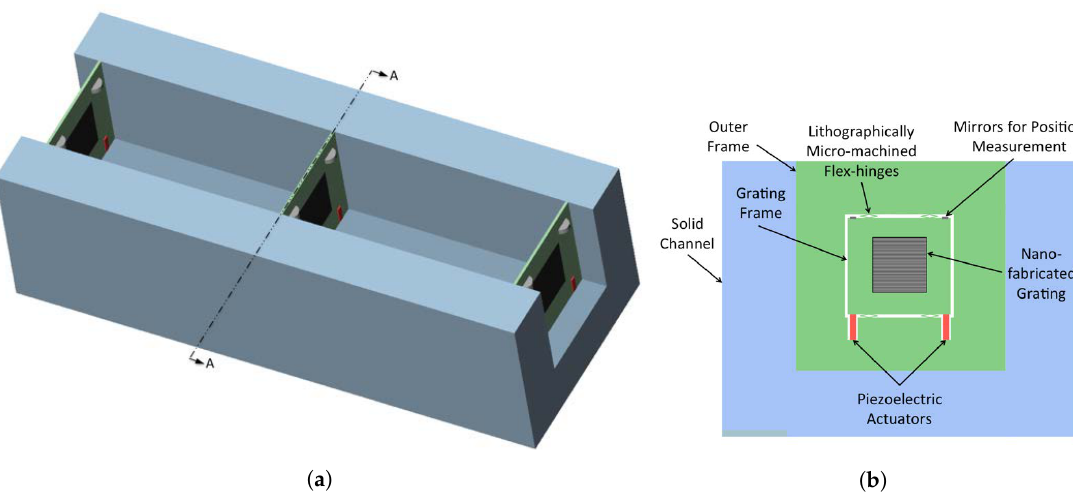
Figure 2. Muonium interferometer support scheme in channel-cut single-crystal silicon optical bench. ( a ) Optical bench with gratings, showing mirrors at upper grating corners for alignment interferometers; ( b ) Section A-A detail showing mounting scheme of each grid within its silicon